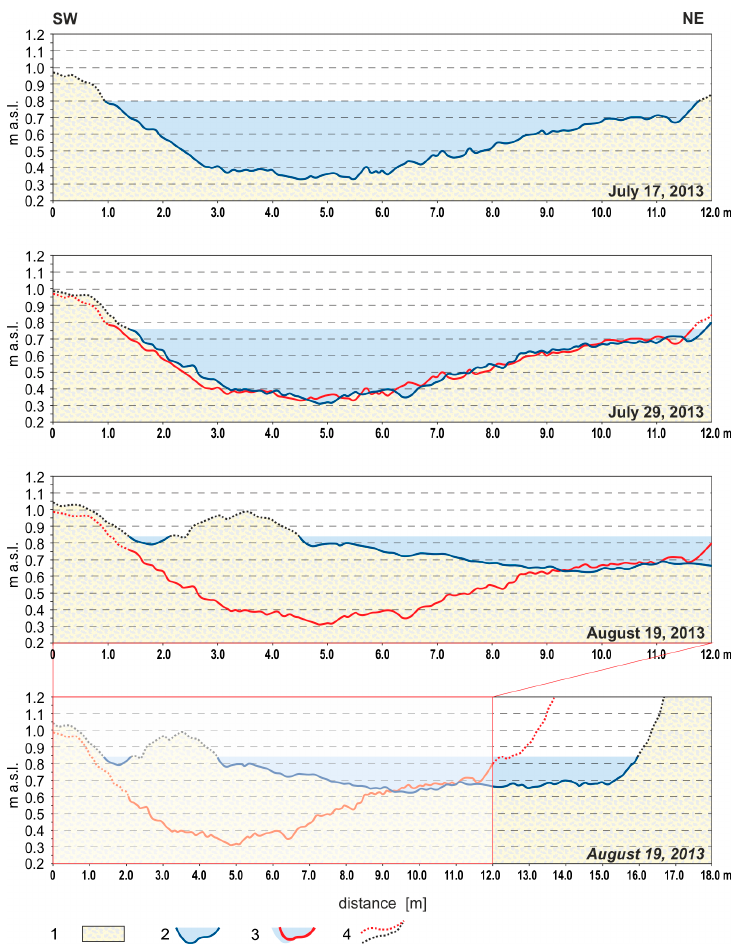
Figure 8. Changes in the channel bottom in cross-section II in 2013: 1. Bedrock, 2. Current stage, 3. Previous stage, 4. Dry streambank.